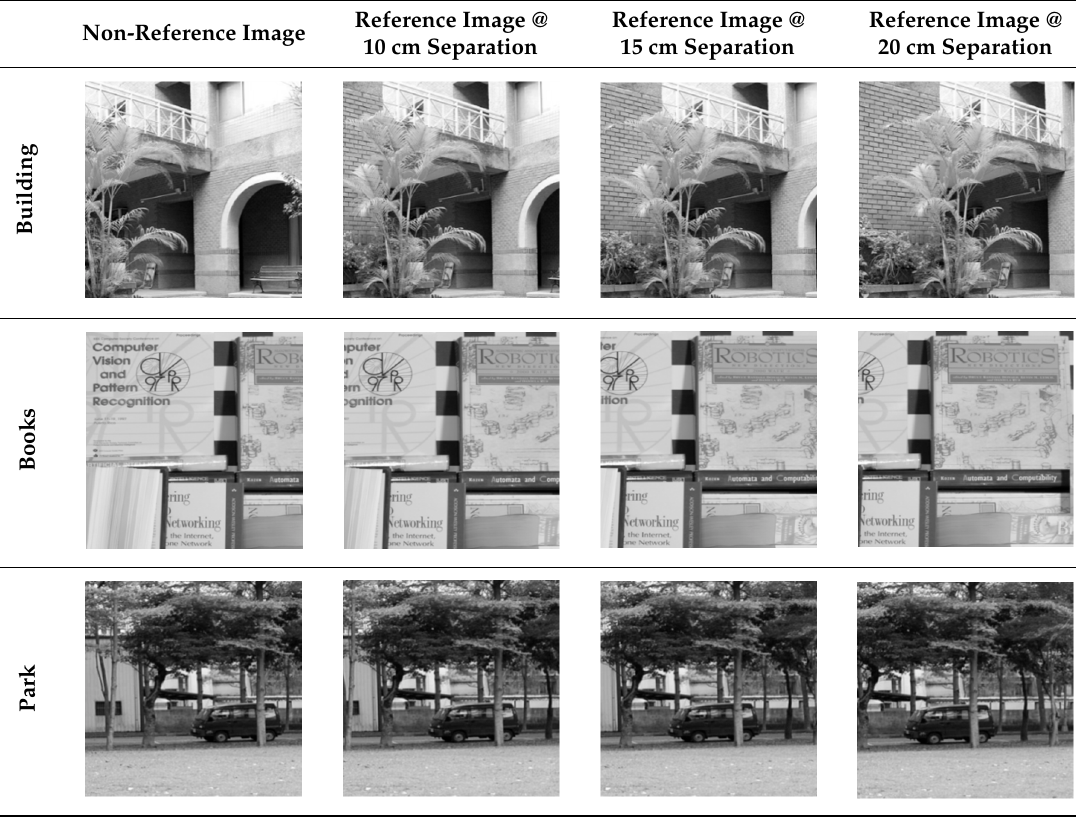
Table 5 . Performance (PSNR (dB)) comparison of using the JMD compression scheme with different camera separations, block sizes, and subrates